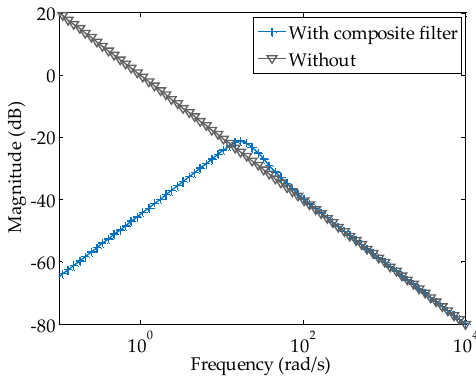
Figure 8. Comparison of the frequency responses of the traditional integration method and composite filter.